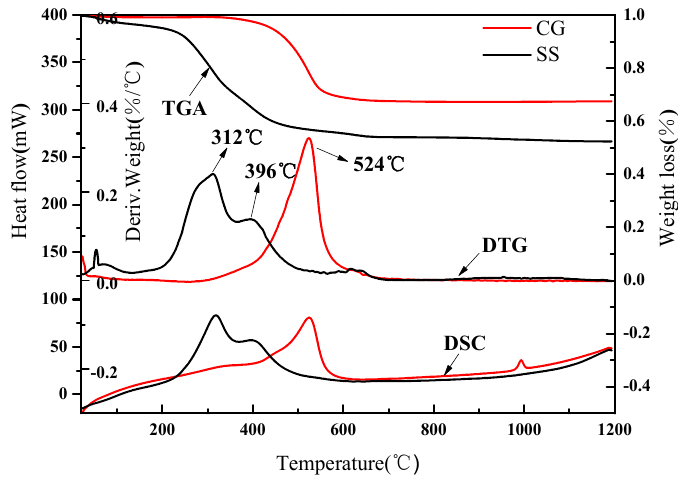
Figure 2. The thermogravimetric (TG), derivative thermogravimetric (DTG) and differential scanning calorimetric (DSC) curves of raw materials.